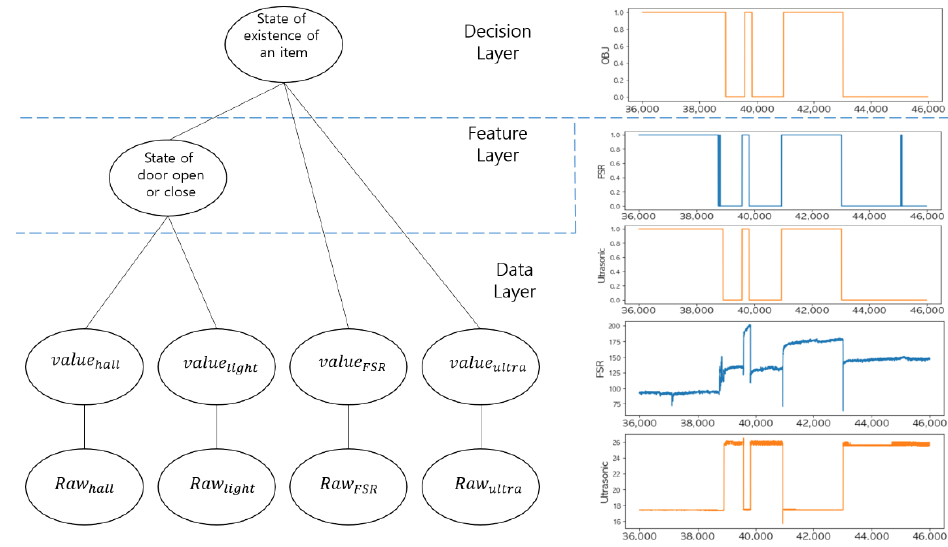
Figure 4. Multi-sensor data fusion with a three-layered structure.